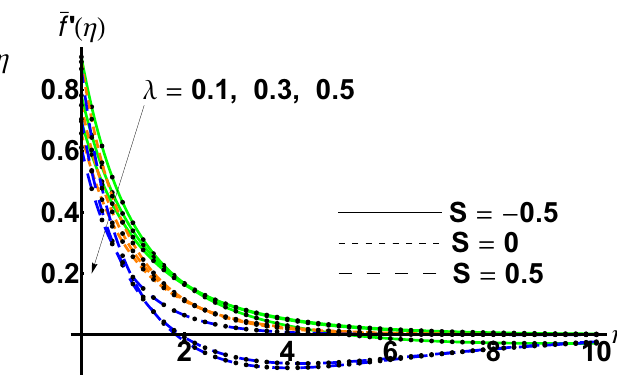
Figure 7: Variation of the horizontal velocity ¯ f ′ ( η ) with increasing of the slip parameter λ for different values of the suction/blowing parameter S : •••••••• numerical solution ; OHAM solution (with lines and dashing lines respectively)